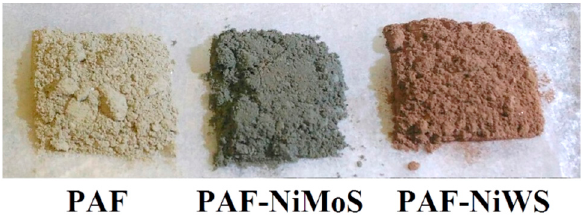
Figure 2. Photographic picture of porous aromatic framework infiltrated with different bimetallic sulfides.